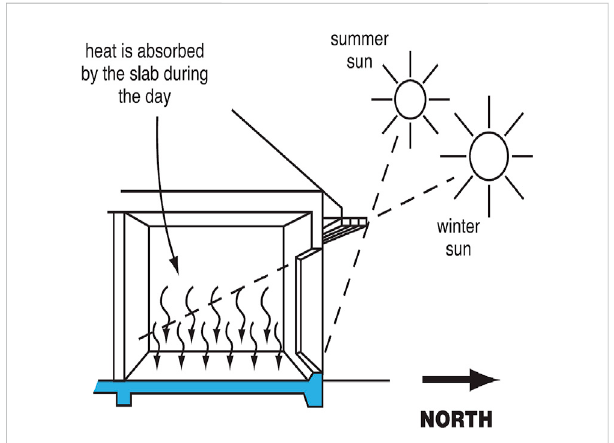
FIGURE 2 Window position at the study location.